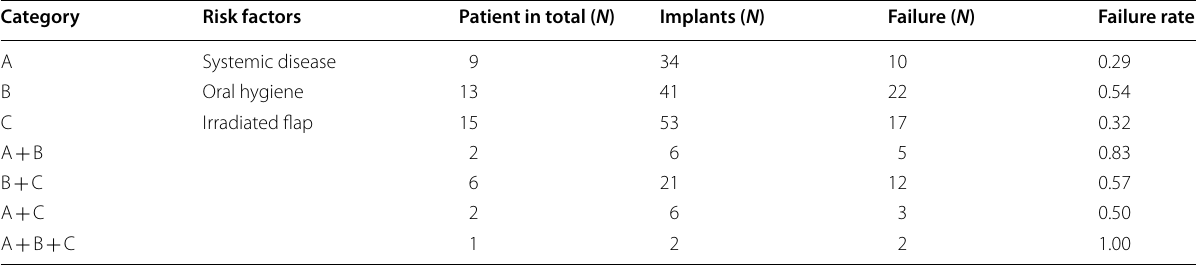
Table 4 Impact of accumulated risk factors on the implant failure rate Category Risk